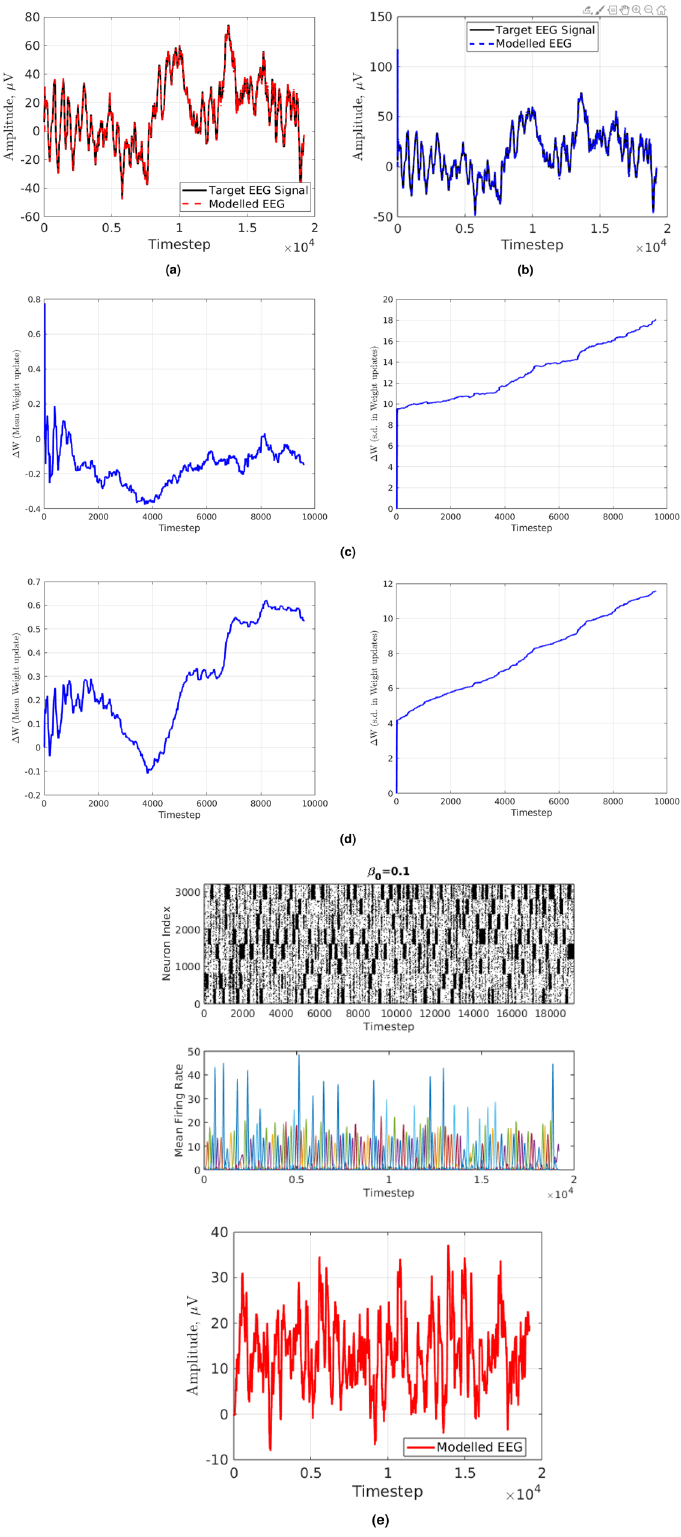
Figure 2. ( a ) Using modified full-FORCE. Black solid line shows the “Target EEG signal”. Red dotted line shows the “Modelled EEG Signal”. ( b ) Using FORCE method as adapted by 27 . Black solid line shows the “Target EEG signal”. Blue dashed line shows the “Modelled EEG Signal”. ( c ) Modified full-FORCE with 1000 neurons. Blue solid line shows mean weight change (left). Blue line shows s.d. weight variation (right). ( d ) Modified full-FORCE with 4000 neurons. Blue solid line shows mean weight change (left). Blue line shows s.d. weight variation (right). ( e ) Modified full-FORCE with 4000 neurons. Raster plot (top). Red Solid line shows “Modelled EEG Signal”